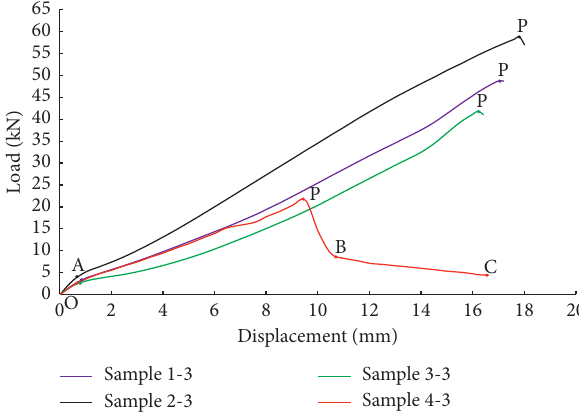
Figure 10: Load-displacement curves of samples with a cement- sand ratio of 1